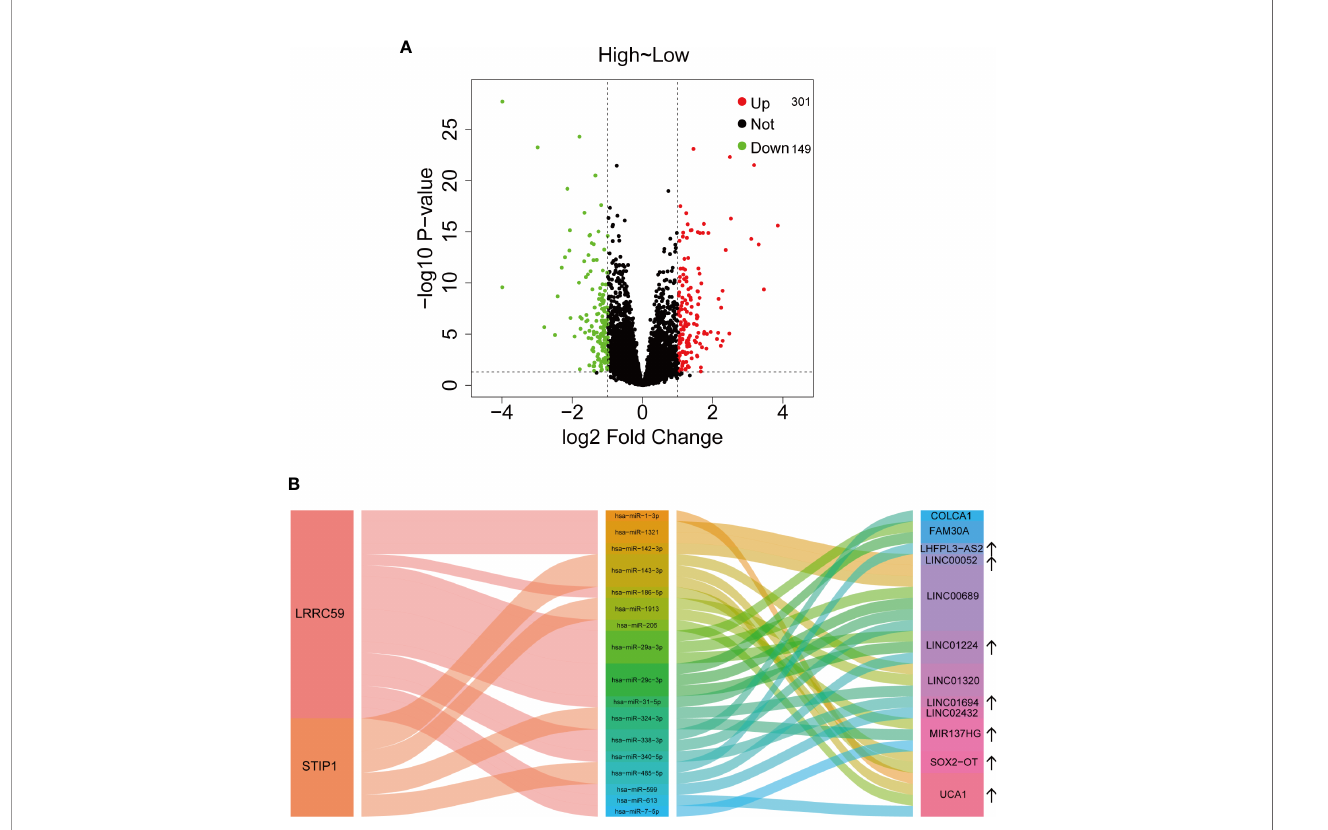
FIGURE 6 | Potential regulatory mechanisms of IGF2BP2. (A) The dysregulated lncRNAs associated with IGF2BP2 expression. (B) Sankey plot illustrating the ceRNA regulatory